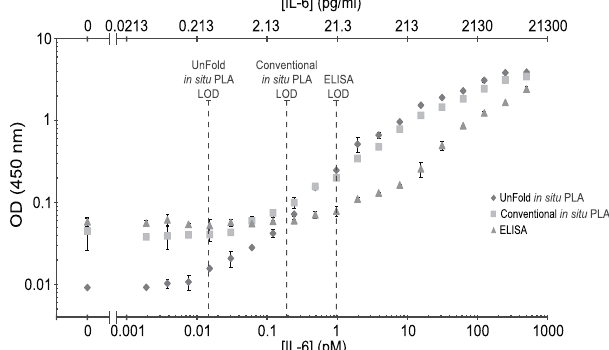
Figure 7. Detection of recombinant IL-6 from solution phase using UnFold probes. Microtiter wells were precoated with capture antibodies, which served to bind the antigen, IL-6. Captured target proteins were then detected using a standard sandwich enzyme-linked immunosorbent assay (ELISA), or via conventional or UnFold in situ PLA probes. In each case, the signals were recorded by an HRP-mediated colorimetric reaction. After addition of the HRP substrate, TMB, the absorbance was recorded by spectrophotometry. The experiment was performed four times and one representative graph is shown. Error bars = Standard deviation of duplicates, dashed lines indicate the experimental LODs.